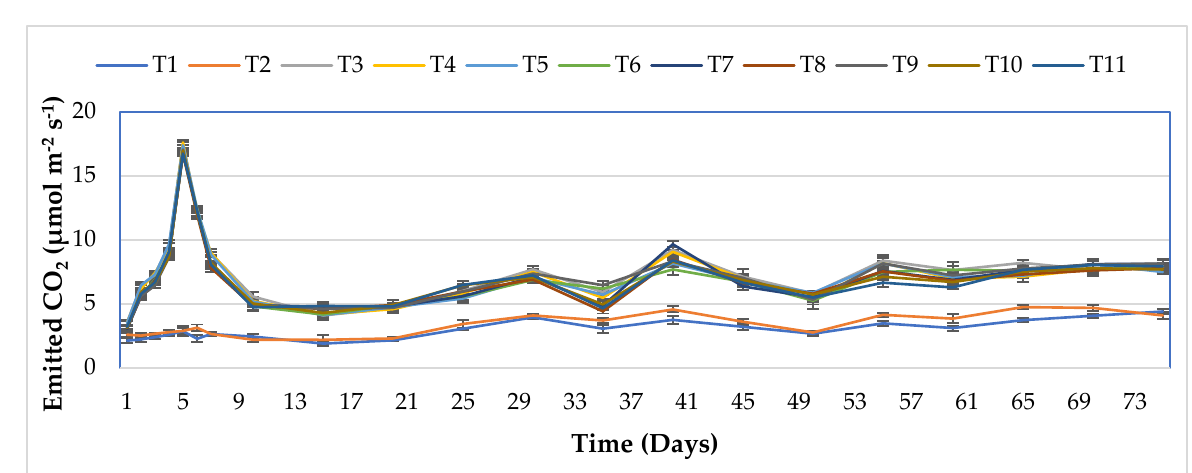
Figure 3. Effect of Treatments on soil CO 2 flux emission in a maize field. Bar errors show ± standard error of four replica- tions. T 1 = No treatments and fertilizer (Control), T 2 = Recommended rate of NPK (t ha −1 ), T 3 = 100% dolomitic limestone + 10 t ha −1 rice husk biochar + 100% TSP, T 4 = 100% dolomitic limestone + 10 t ha −1 rice husk biochar + 75% TSP, T 5 = 100% dolomitic limestone + 10 t ha −1 rice husk biochar + 50% TSP, T 6 = 75% dolomitic limestone + 10 t ha −1 rice husk biochar + 100% TSP, T 7 = 75% dolomitic limestone + 10 t ha −1 rice husk biochar + 75% TS P, T 8 = 75% dolomitic limestone + 10 t ha −1 rice husk biochar + 50% TSP, T 9 = 75% dolomitic limestone + 15 t ha −1 rice husk biochar + 100% TSP, T 10 = 75% dolomitic